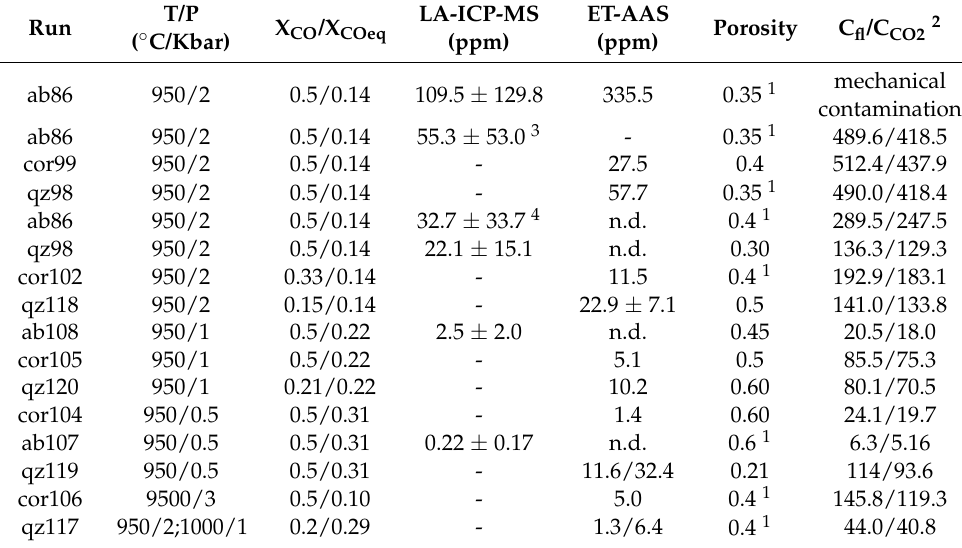
Table 1. Results of fluid traps analyses and Pt concentration in the